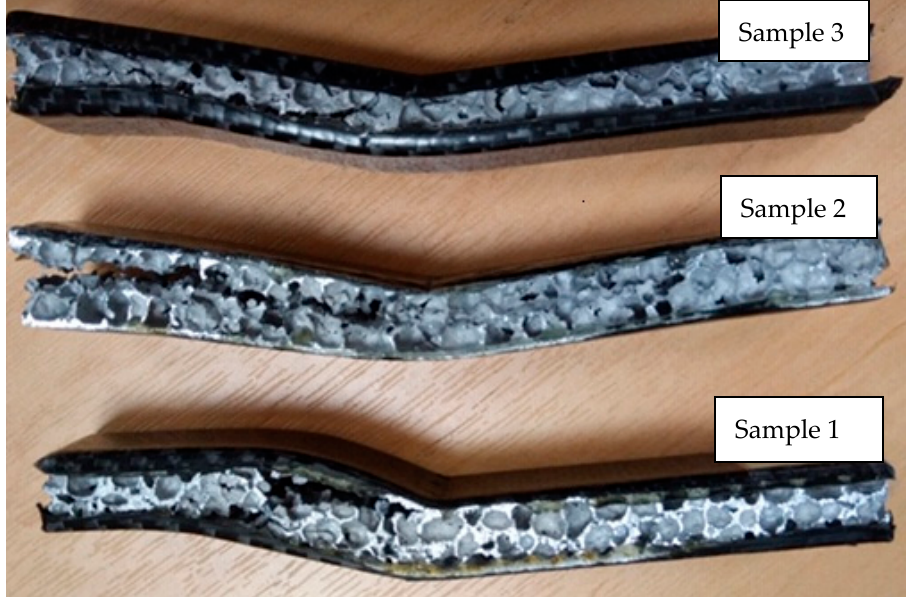
Figure 6. AFSS laminated CFRP samples after carried the bending load.